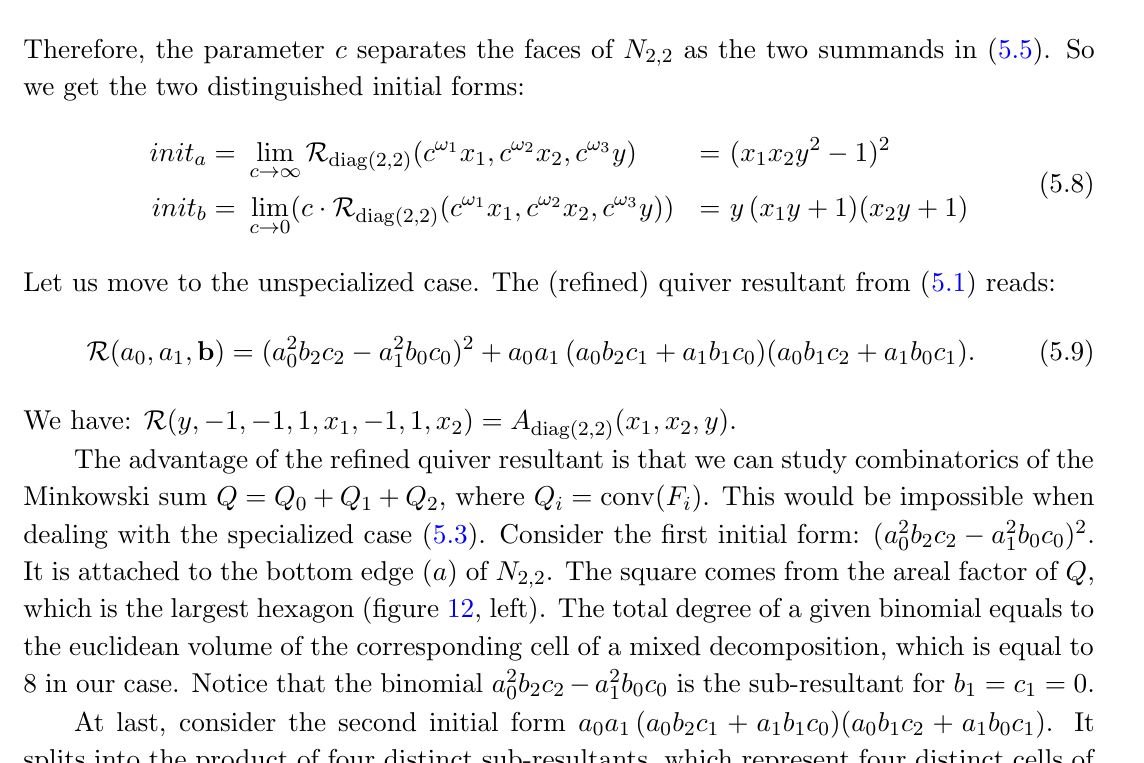
Figure 11 . GKZ polytope N 2 ; 2 , along with the monomials (blue nodes) of A the ( x; y )-projection ((cid:12)gure